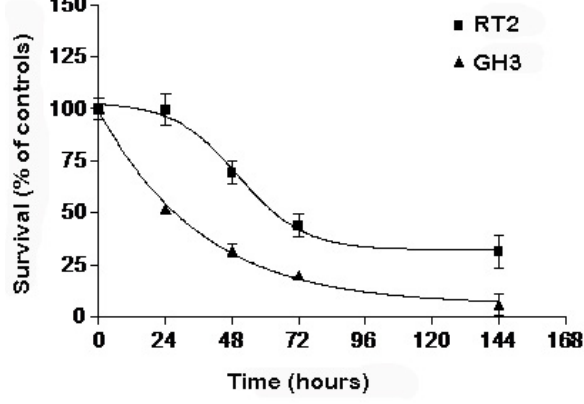
Figure 1. Kinetics of CV antitumoral effect on brain tumor cell lines. Brain tumor cells were treated with CV (1 μg/mL) for 24, 48, 72 and 144 hours. Cell viability was determined by MTT assay. Results are presented as survival ratio compared with the control group (untreated cells). GH3 and RT2 cells were sensitive to CV in a time-dependent